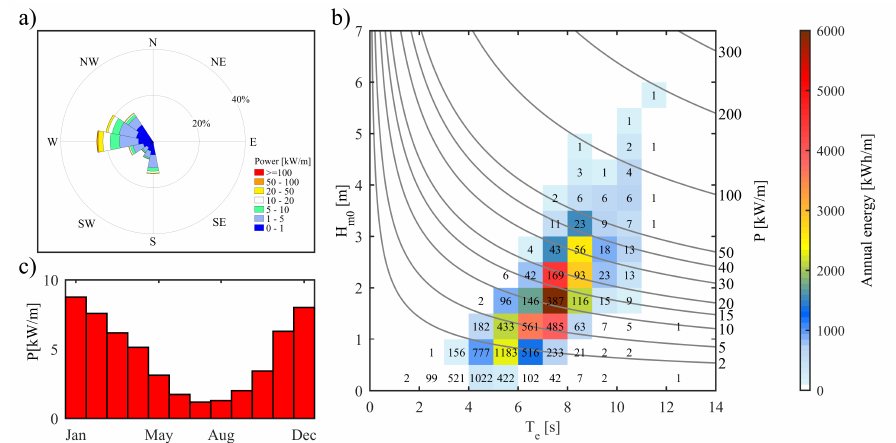
Figure 16. Characterisation of mean yearly wave energy and wave energy flux climate at point HT3; ( a ) the wave energy flux rose; ( b ) the scatter plot of H m e T e , the colour scale indicates annual energy 0 per meter of wave front (kWh/m), the numbers within the bins indicate the occurrence of sea states (hours/year) and the isolines specify the wave energy flux; ( c ) the histograms of the monthly mean wave energy flux.